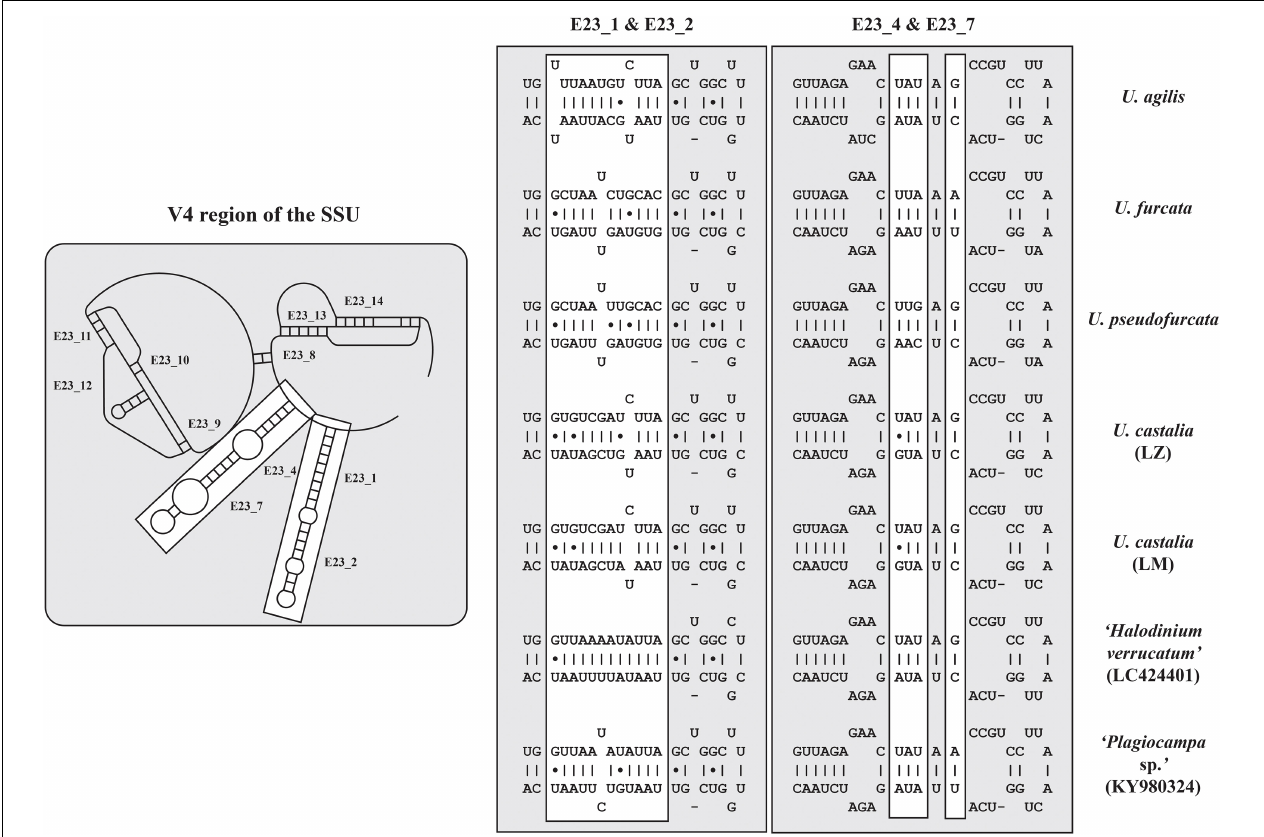
FIGURE 9 | V4 secondary structures of the investigated Urotricha strains. The variable regions are marked by white boxes. The structures of E23_1/E23_2 and E23_4/E23_7 were calculated with mfold. The line graphic was drawn with PseudoViewer. LM, Lake Mondsee population; LZ, Lake Zurich population.